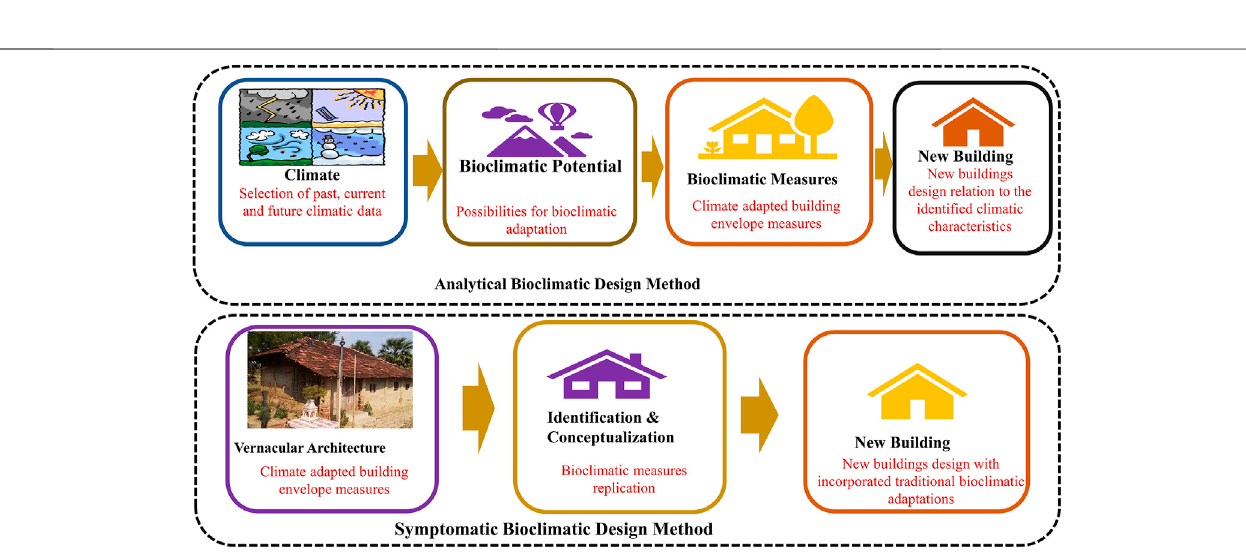
FIGURE 10 | Design process of analytical and symptomatic bioclimatic design methods (Ko š ir, 2019).